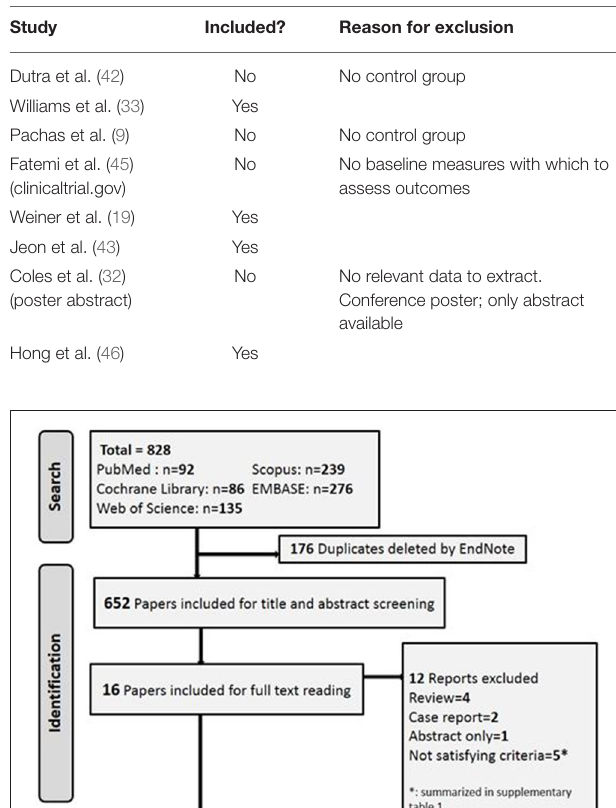
TABLE 1 | List of studies considered at the final stage of study selection.